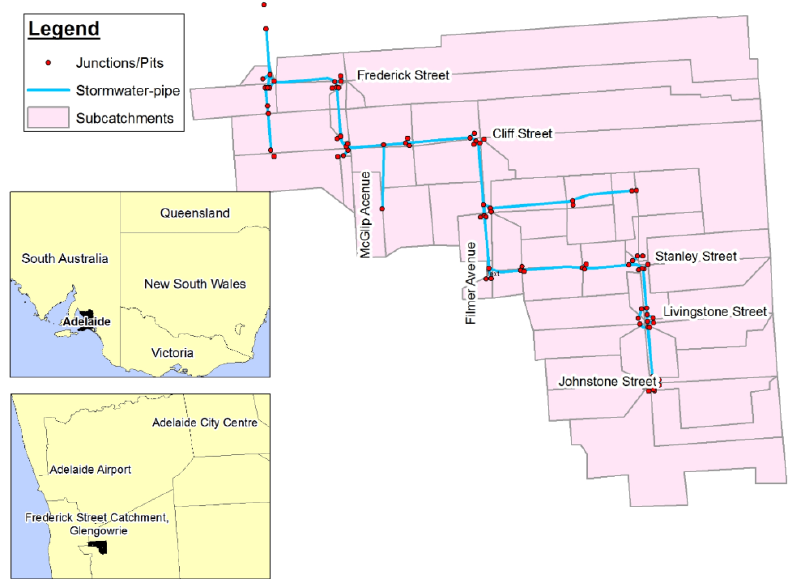
Figure 2. Location and outline of the Frederick Street catchment.